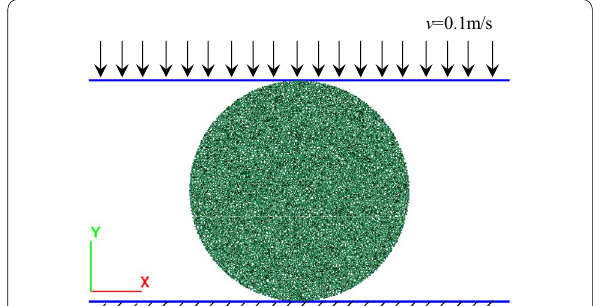
Fig. 10 Numerical STS test created in